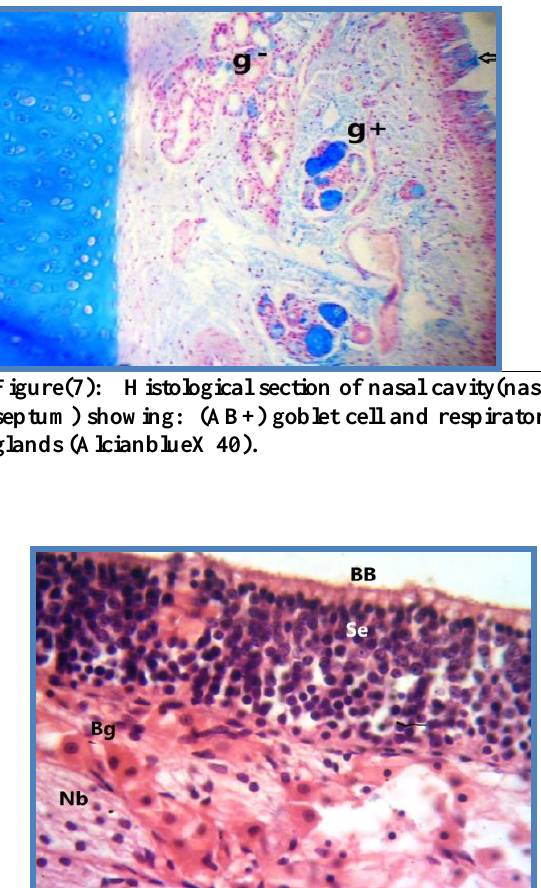
Figure (5): Histological section of nasal cavity (respiratory) showing: goblet cells PAS+ (white arrow), goblet cells AB+(yellow arrow), p- PAS+ acini , A- AB+ gland.(PAS-AB stain X100).